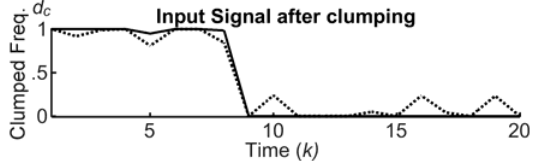
Figure 6. The clumping process, with two levels, α 1 = 0.25 and β 1 =